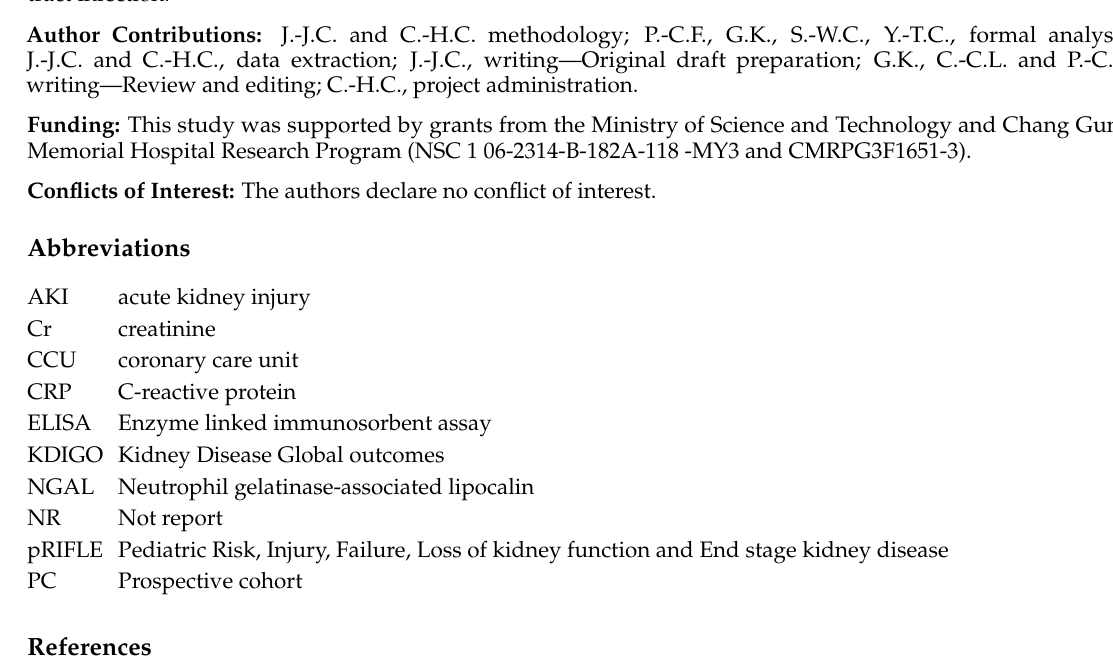
Table S1: Primary reasons for exclusion of excluded studies, Figure S1. Diagnostic performance of the three studies providing data on urinary calprotectin with normalization to urine creatinine, Figure S2. Symmetric SROC according to the cutoffs of the three studies with urinary calprotectin with normalization to urine creatinine, Figure S3. Diagnostic performance of urinary calprotectin with three studies excluding patients with urinary tract infection, Figure S4. Symmetric SROC according to the cutoffs of the three studies excluding patients with urinary tract